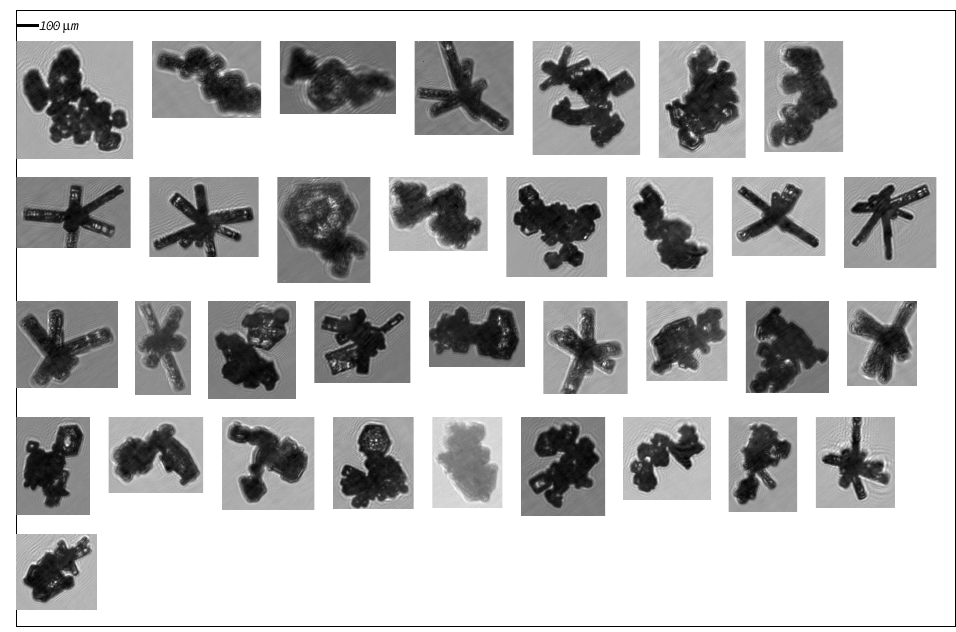
Fig. 12: CPI images at the edge of the cloud ( − 11 . 2 ≤ lat ≤ Fig. 12. CPI images at the edge of the cloud ( − 11 . 2 ≤ Lat . ≤ − 11 . 1) during leg 2. Note that bullet-rosettes are observed in this region, which suggests that new ice crystals are being nucleated. This occurs in thin cloud and is probably due to the vertical motion from the gravity waves (shown in Fig.